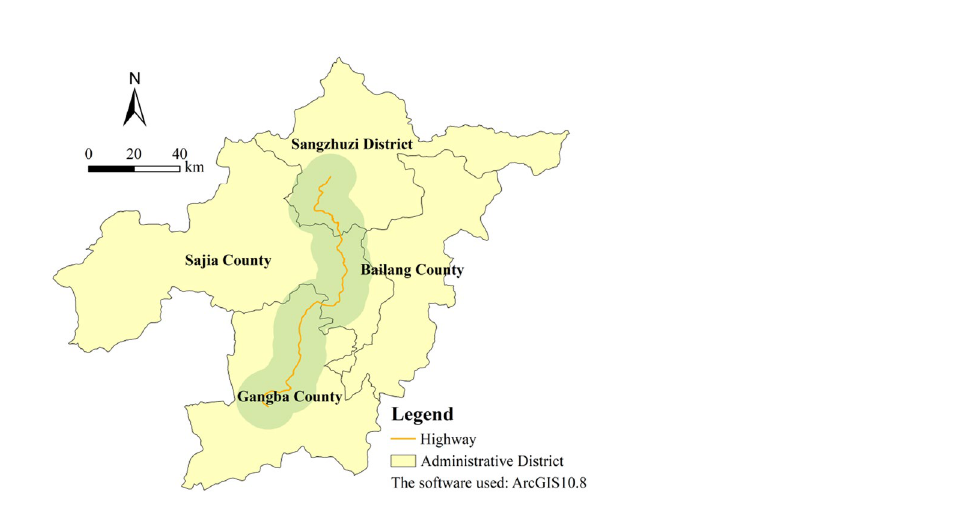
Figure 2. 10-km buffer zone of the highway from Qumei to